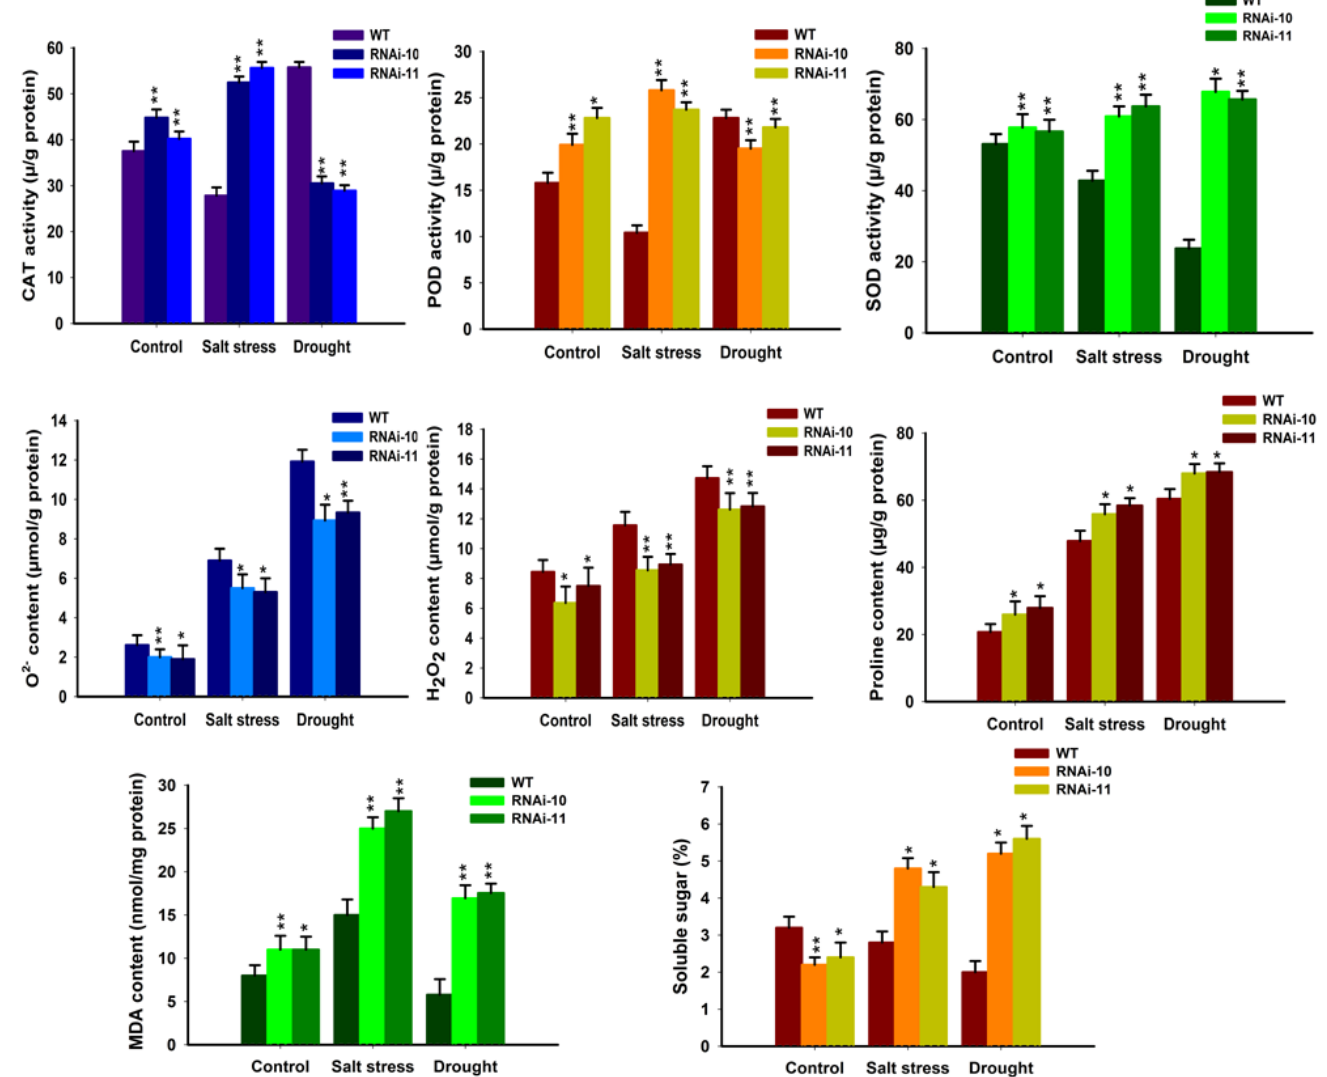
Figure 8. Down-regulation of SlGRAS10 elevates ROS scavenging ability. CAT, POD, and SOD activities and O 2 − , H 2 O 2 , proline, MDA, and soluble sugar contents in the leaves of SlGRAS10 -RNAi (L10, L11) and WT plants under control and stress conditions. The date represents the mean ± SE of three independent replicates. *, ** indicates a significant difference ( p < 0.05, p < 0.01) between transgenic and wild-type plants.